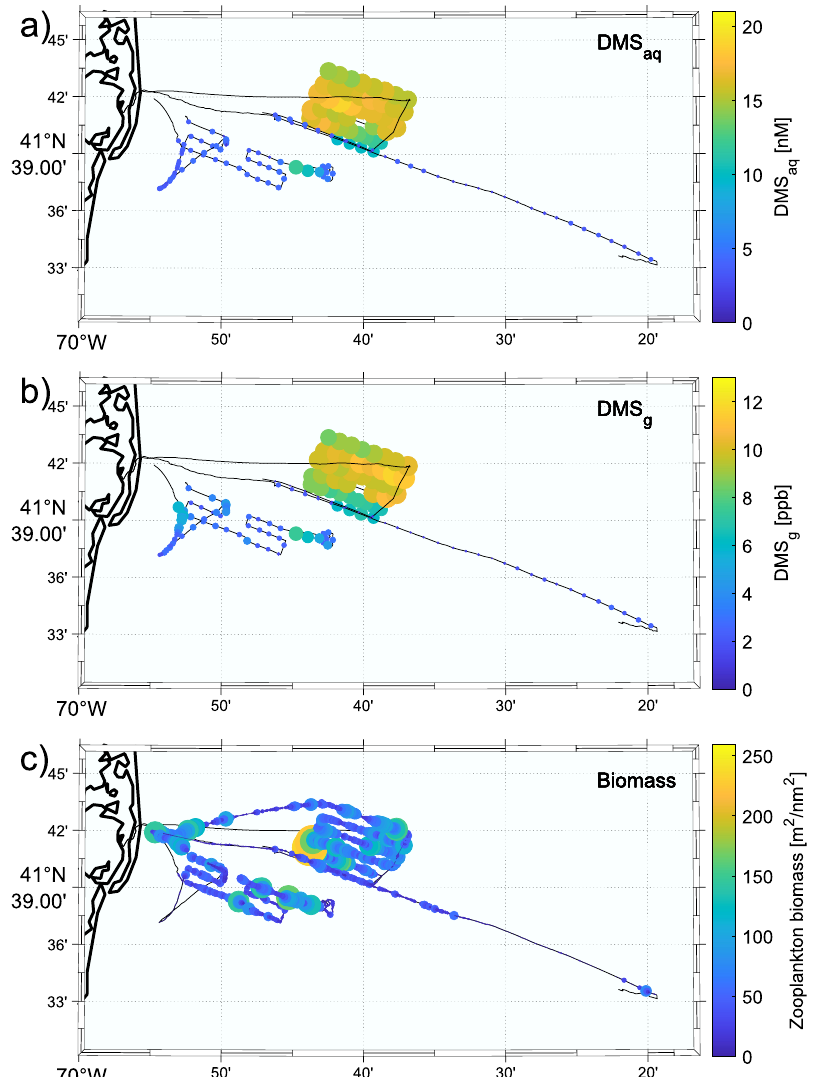
Fig. 1 Dimethyl sul fi de (DMS) concentration in seawater (DMS aq ) and air (DMS g ) along with concurrent acoustic measurements of zooplankton biomass (Nautical Area Scattering Coef fi cient (NASC)) off the coast of Cape Cod, MA, USA. The colour and size of the dots indicate the value of the measurement. Black lines represent the vessel track when no data were collected or where the measured value was zero. a DMS concentration in seawater (DMS aq ). b DMS concentration in air (DMS g ). c Zooplankton